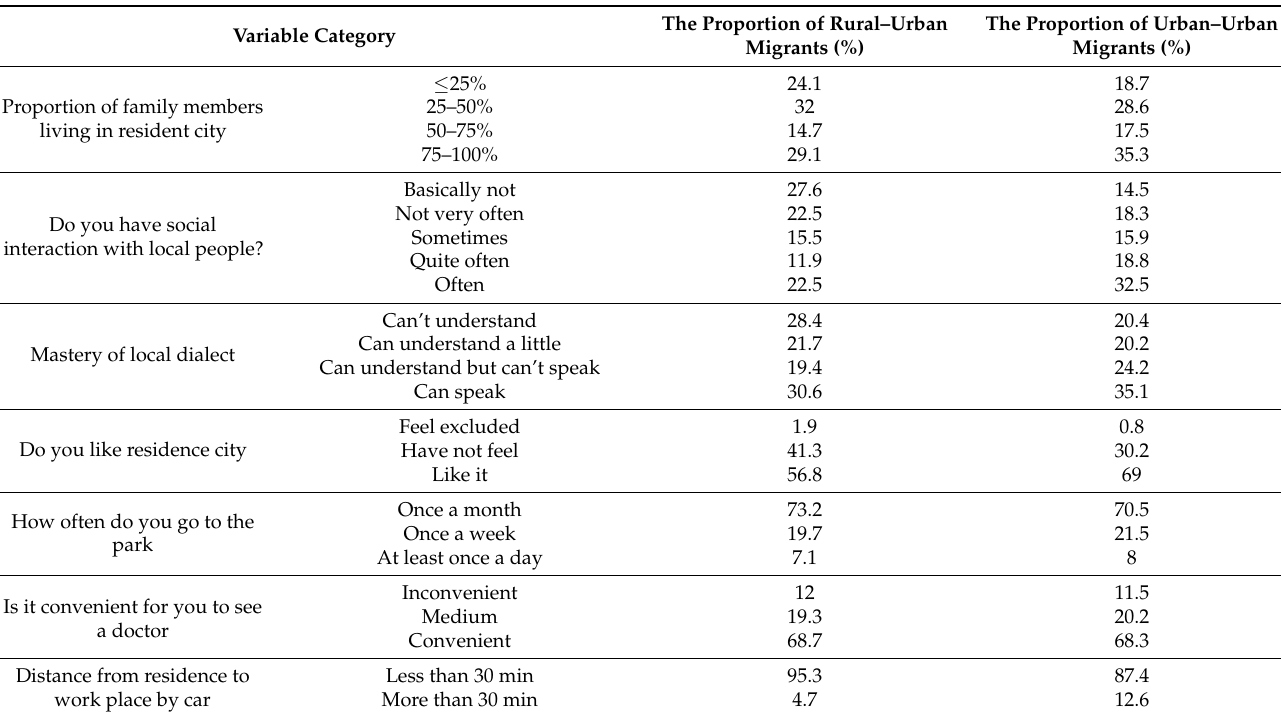
Table 5. Family and social characteristics of rural–urban migrants and urban–urban migrants. Variable